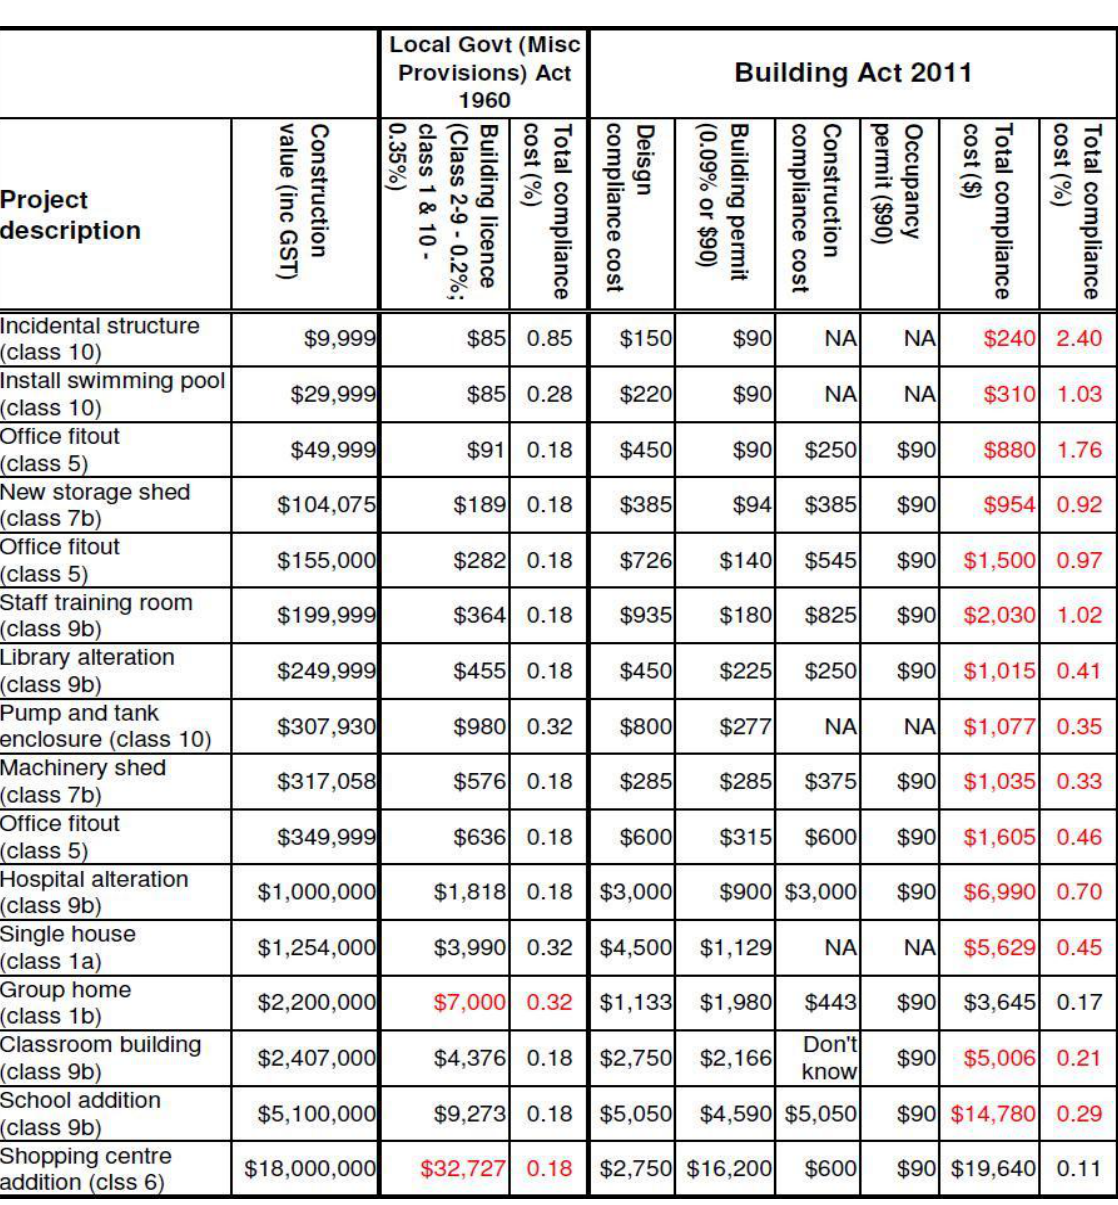
Table 3 Data for 16 building projects constructed since 2 April 2012 with construction values and compliance costs under the Building Act 2011 and the Local Government (Miscellaneous Provisions) Act 1960, where the greater compliance cost is marked in